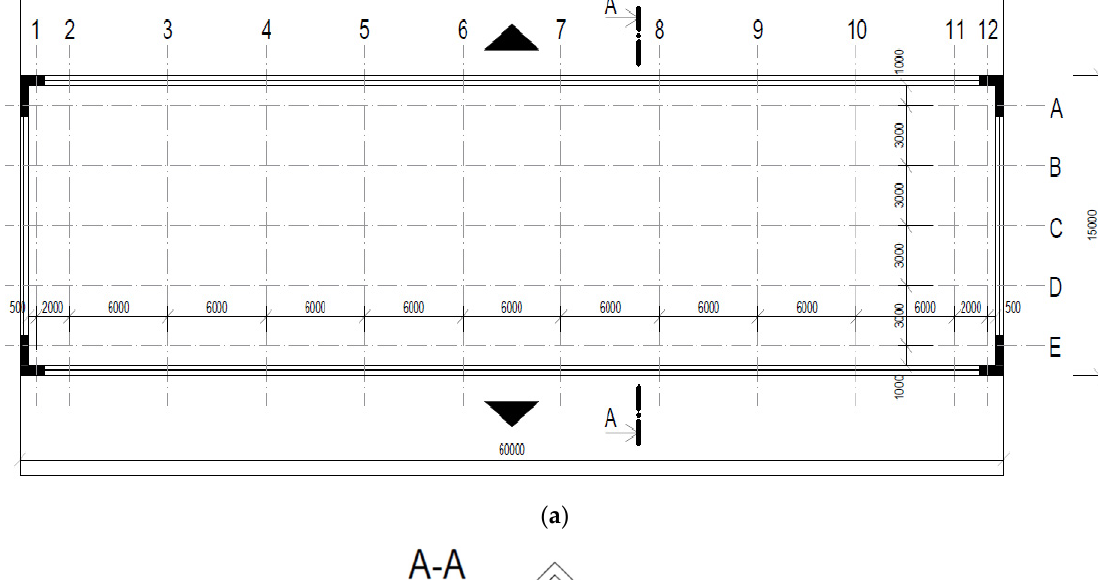
( d ) Figure 4. The reference hall selected for daylight simulations; Source for situation maps: https://www.google.sk/maps/search/Ko%C5%A1ice,+Park+Komensk%C3%A9ho/@48.7325581,21.2 46384,581m/data=!3m2!1e3!4b1 (accessed on 6 April 2022) . ( a ) situation map. ( b ) external view of hall. ( c ) internal view of hall building. ( d ) render of the selected hall by RADIANCE . In a hall environment where a visual task is performed, the brightness of the surfaces is important. It is determined based on the reflectivity and illuminance of surfaces. The